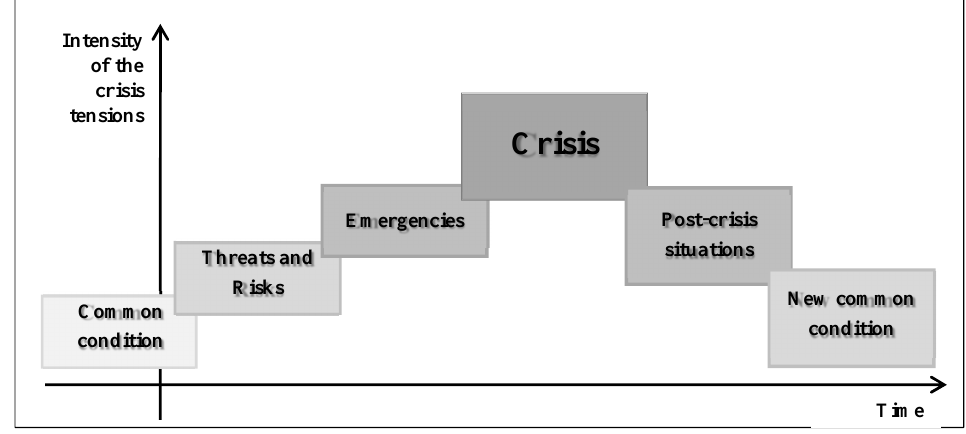
Figure 1 – Continual approach to crisis management in local government Source: elaborated from Antušák